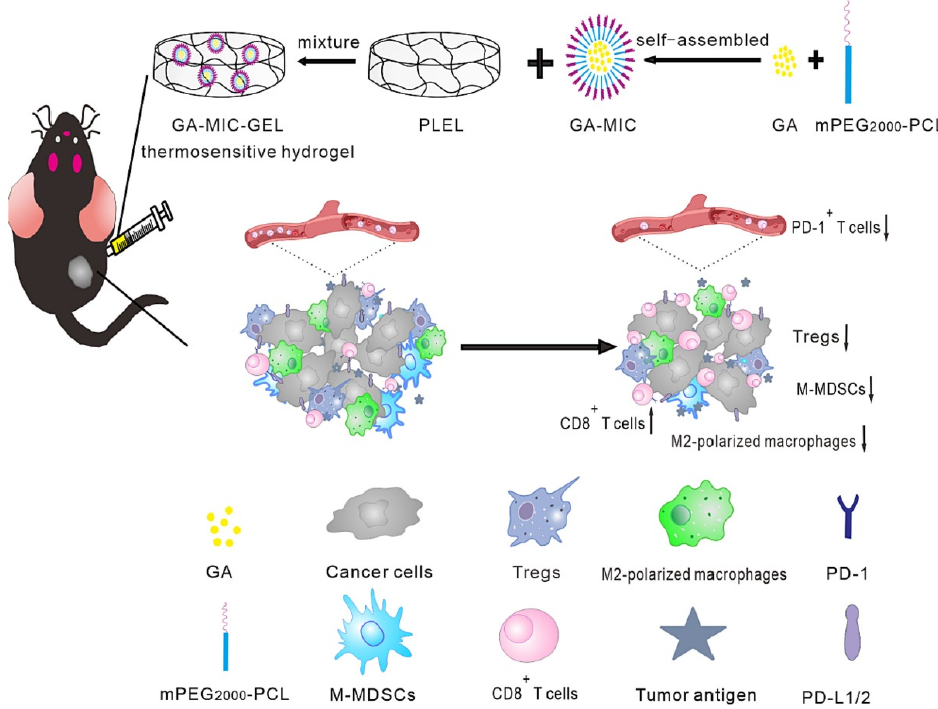
Figure 8. Schematic diagram of the in situ thermosensitive hydrogel containing GA micelles for improving anti-tumor immunity against OSCC. The GA micelle-encapsulated PLEL sol was locally injected into the tumor, formed hydrogel at the body temperature, and continually released GA in situ, thus exerting the chemotherapeutic effect and anti-tumor immune activation. The mice treated with GA-MIC-GEL showed increased cytotoxic T cells as well as reduced immunosuppressive cells at the tumor sites, suggesting the T cell activation and reversal of the tumor immune microenvironment. Besides, the systemic expression of PD-1 in GA-MIC-GEL treated mice also decreased. Reprinted with permission from Ref. [56] Copyright 2022